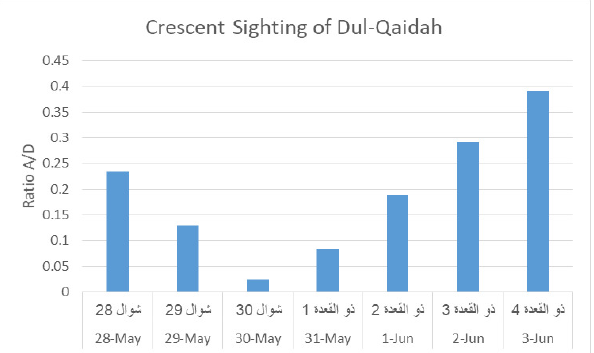
Figure 12. The Present Model Crescent Visibility of Shaban 1444 H.